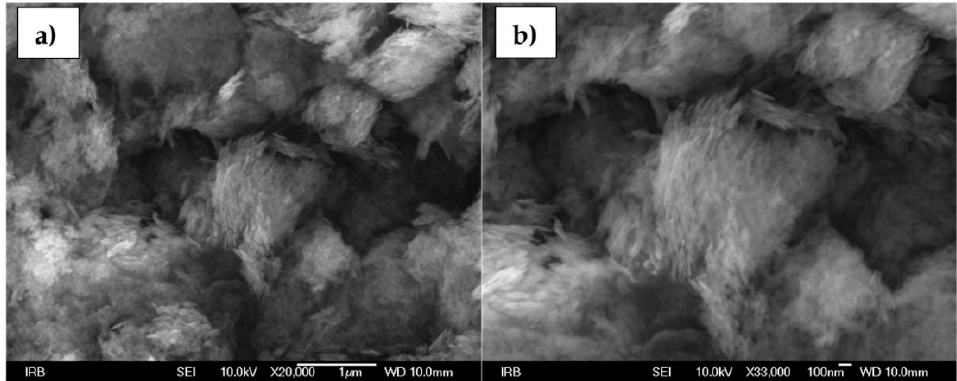
Figure 3. SEM images of boehmite NPs at ( a ) 20,000× and ( b ) 33,000× magnification. Figure 4 represents EDS data of boehmite NPs. The atomic ratio of 32% Al and 68% O matches for γ -AlO(OH) particles.